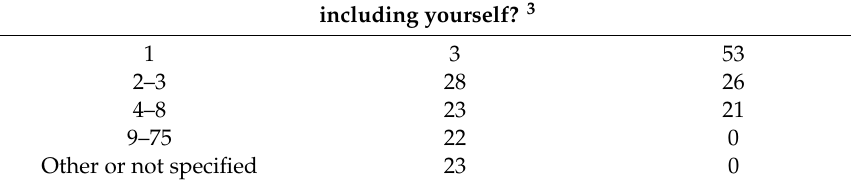
1 : N denotes the size of the sample. 2 : The European regions are defined according to United Nations geoscheme for Europe [24]. 3 : The independent sample T-test shows significant di ff erence between the two samples (F = 9.343; Sig =